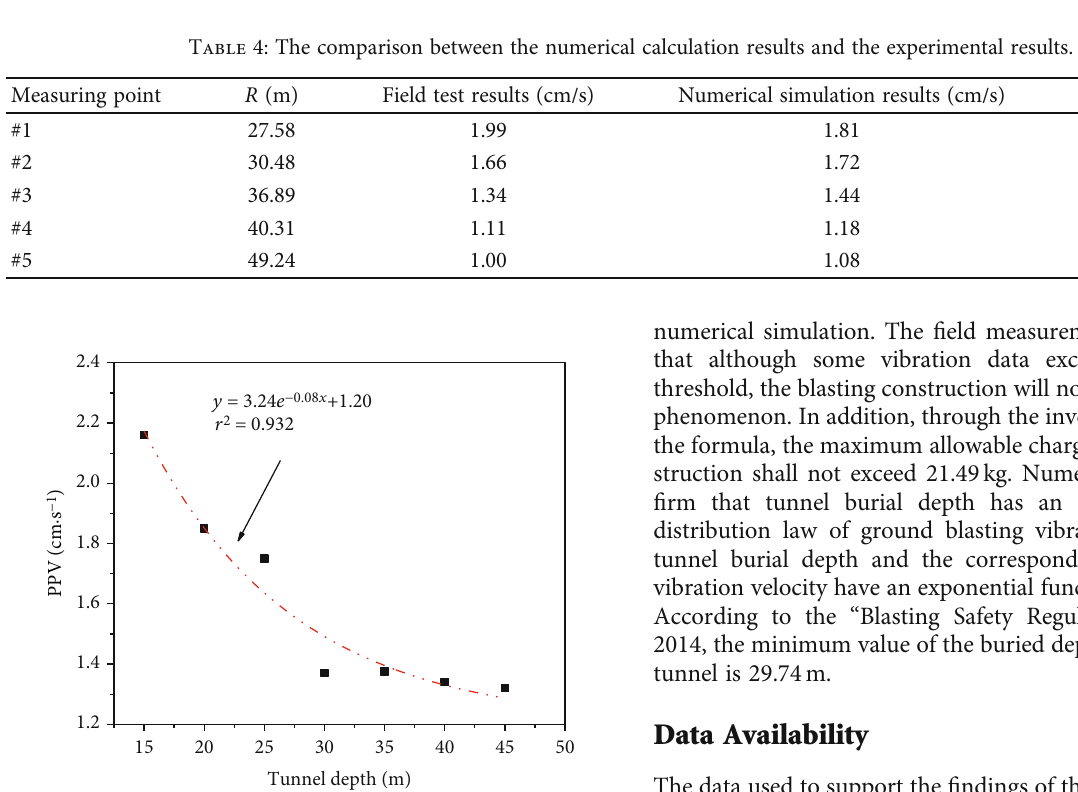
Figure 9: Relationship between tunnel depth and corresponding vibration velocity.